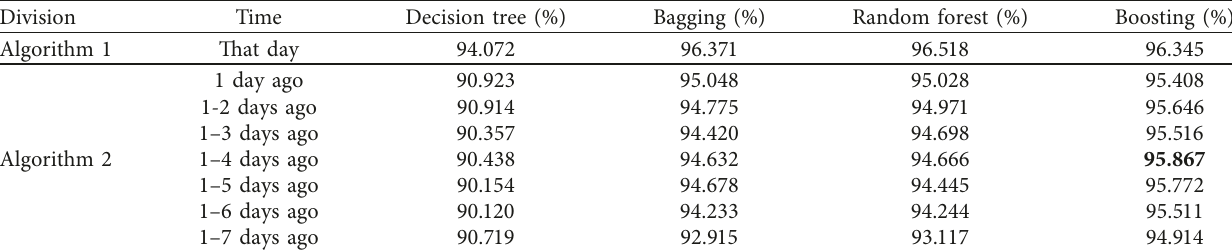
Figure 12: Predictive evaluation concept. Table 5: Evaluation of prediction performance by